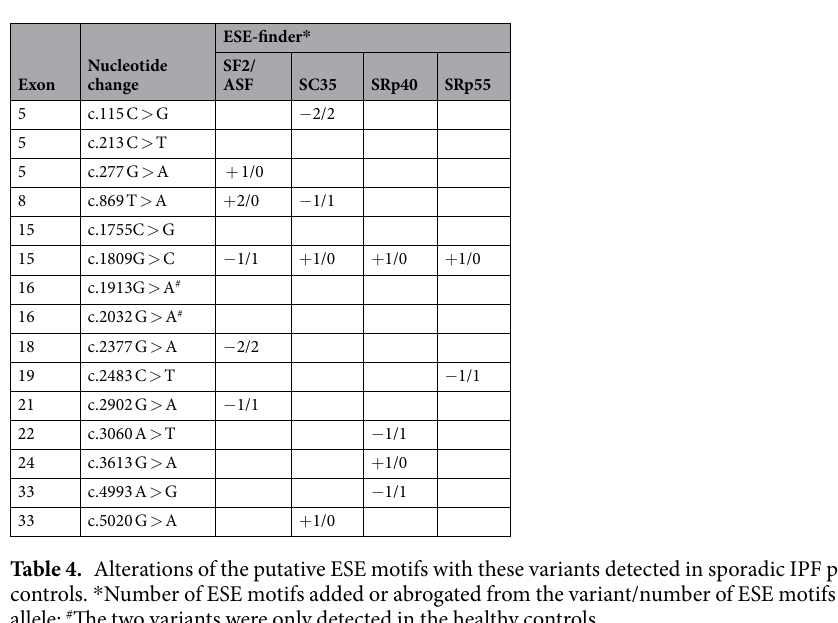
Figure 1. Structural diagram of the ABCA3 protein and the distribution of the missense variants detected in ABCA3 in this study. * The two variants were detected in the healthy controls.